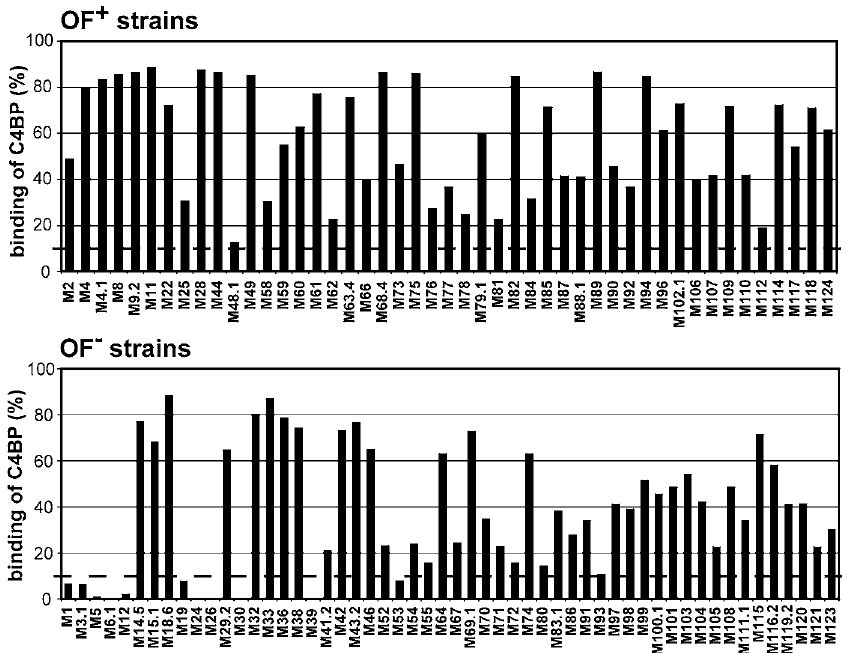
Figure 2. Binding of Human C4BP to S. pyogenes Strains of Different M Types Strains of the M types indicated were analyzed for ability to bind radiolabelled C4BP. Upper panel: OF þ strains. Lower panel: OF (cid:1) strains. Only strains that bound Fg, as determined in parallel tests, were used for the analysis because binding of Fg is a characteristic property of S. pyogenes isolates expressing members of the M protein family. Binding is expressed as percent of added radioactivity. The threshold for binding of C4BP was set at (cid:2) 10% binding (dashed line). Background binding to an M-negative strain ( ; 3%) has been subtracted. All strains were tested at least twice, with duplicate samples, and the results were highly reproducible. For each strain, data from one experiment are shown. The data include binding data for one allelic variant per M type, except that data for both M4 and M4.1 are included. For strains of some M types, several allelic variants were tested and in most cases these strains did not differ in ability to bind C4BP (unpublished data). DOI: